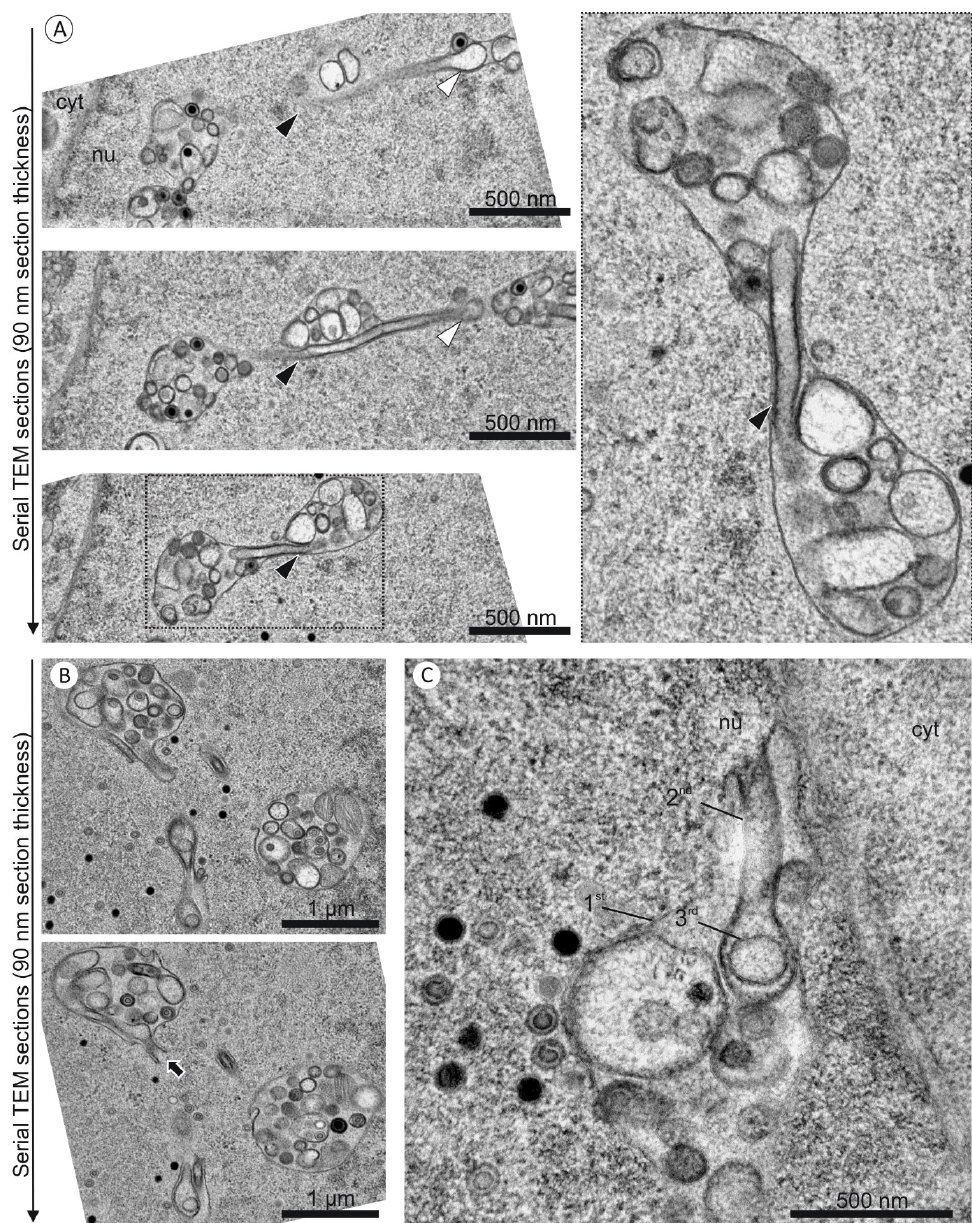
Figure 7. (Serial-)TEM images of nuclear infoldings in HCMV infected fibroblasts at five days post infection. ( A , B ) The sample used for FIB/SEM tomography was objected to serial ultrathin sectioning. The images are captured from two different nuclei. ( A ) Three subsequent images through an infolding show a tubular segment with a 2nd order infolding (arrowheads); ( B ) The lower image shows an opening of a 2nd order infolding towards the nucleoplasm (arrow); ( C ) A standard TEM image of an independent experiment also shows the opening of a 2nd order infolding towards the nucleoplasm.